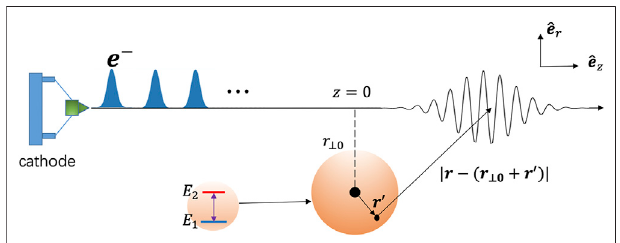
FIGURE 1 | Setup of free-electron bound-electron resonant interaction. A beam of multiple fi nite size or modulation-correlated QEWs interacts with a bound electron which is modeled by a quantum two-level